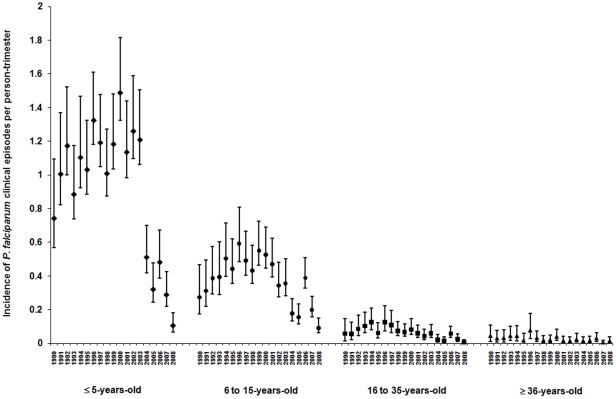
The incidence rate (mean and SEM) of clinical P. falciparum episodes per person-trimester (PFA) according to age classes (from left to right on the X-axis) <5 years, [5–15], [15–35] and ≥35 years that best describe the effect of age on PFA.